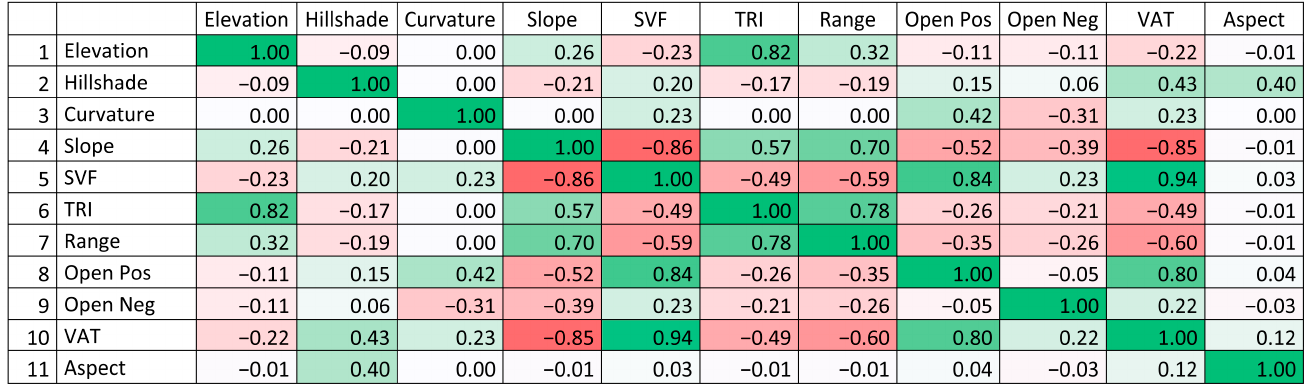
Figure 10. Correlation coefficients (r) among the input layers. The green color indicates a directly proportional correlation, and the red color indicates an inversely proportional correlation between the layers (the darker color, the stronger the correlation).